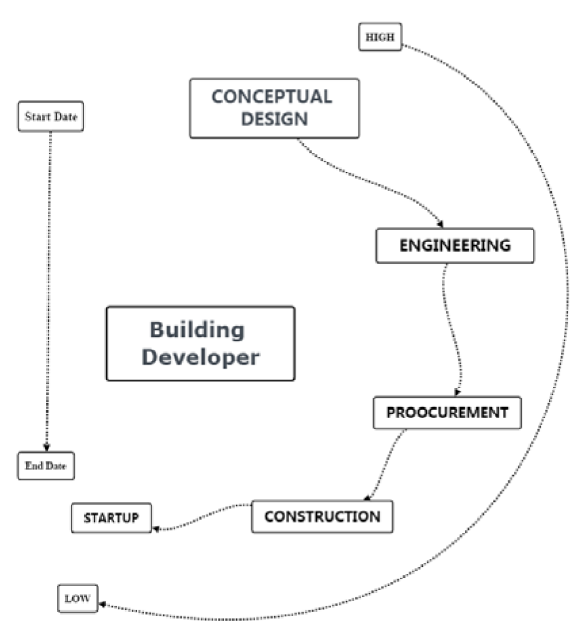
Figure 1. Time/safety influence curve (Szymberski,